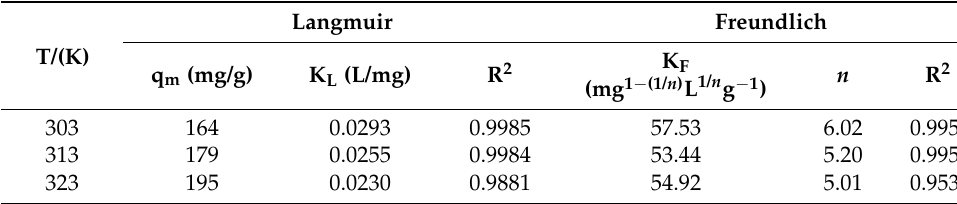
Table 4. Parameters of Langmuir and Freundlich isotherms for the adsorption of Zn 2+ .